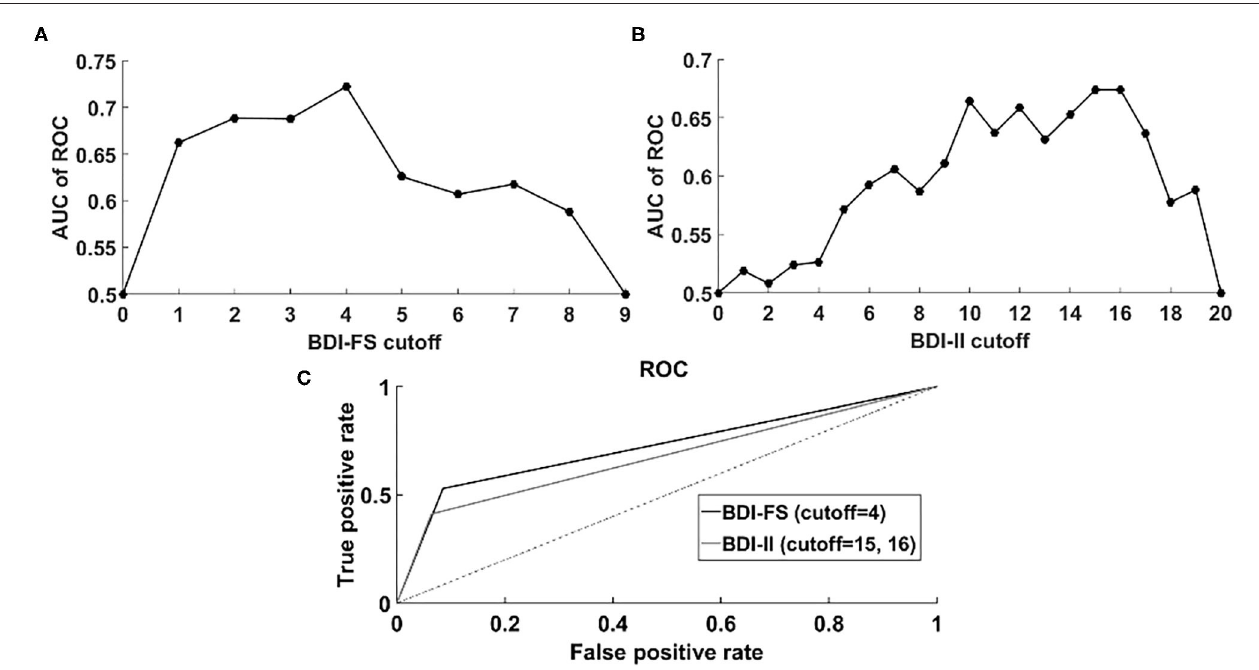
FIGURE 1 | “Area under ROC” (AUC) analysis. (A) AUC of ROC corresponding to BDI-FS across different cutoffs: 0–9. It is noticeable that highest performance is achieved at cutoff = 4; (B) AUC of ROC corresponding to BDI-FS across different cutoffs: 0–20. It is noticeable that highest performance is achieved at cutoff = 15 and 16; (C) ROC of BDI-FS (cutoff = 4) corresponding to logistic regression model: depression-state = 2.4927*BDI-FS − 1.6818, p < 0.001 (coefficient and intercept) and ROC of BDI-II (cutoff = 15 and 16) corresponding to logistic regression model: depression-state = 2.3289*BDI-II − 1.4816, p = 0.0026 (coefficient), p < 0.001 (intercept). For the considered sample of PD-MCI patients, better performance of BDI-FS than BDI-II was